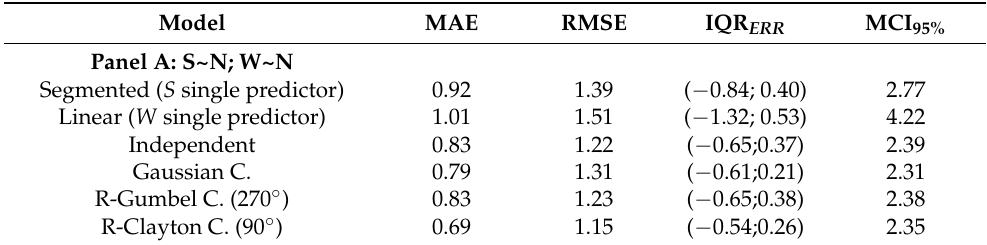
Table A1. Predictions comparison of the considered models with simulated data from Equation (A1) and errors distributed as multinormal Equation